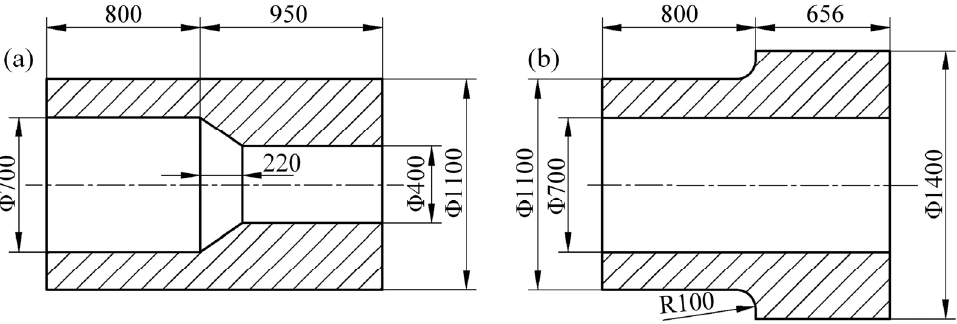
Table 1. Different preforming design schemes.